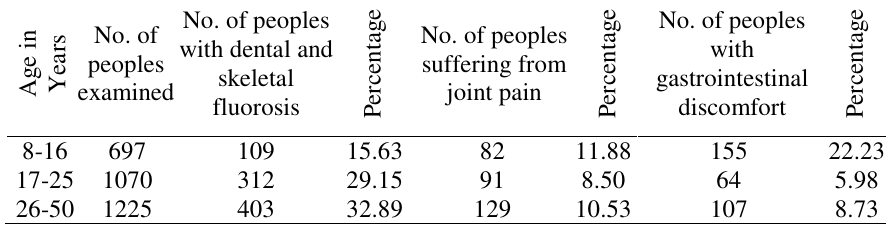
Table 4. The Clinical symptoms of fluorotic patients from Muddebihal